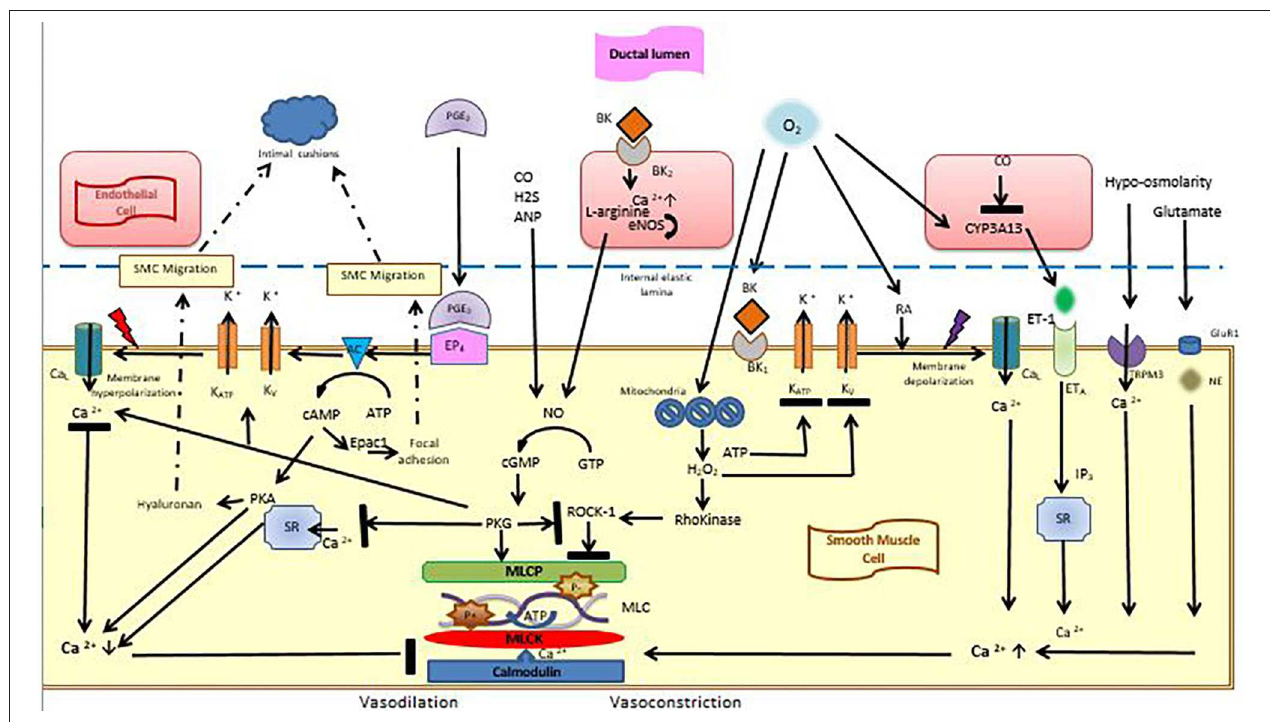
FIGURE 1 | Vasoconstrictive and vasodilatory effects in the ductal smooth muscle cell. Smooth muscle cells are lined with an internal elastic lamina, on which endothelial cells re¸side. Vasodilation is maintained by the interaction of PGE2 with its receptor EP4, which triggers potassium outflow through voltage-sensitive potassium channels, which leads to membrane hyperpolarization. Thereby, calcium entry into the cells decreases and binding of calmodulin to MLCK is inhibited. cAMP and cGMP are also effective during this process. After birth, high oxygen tension, which is sensed through the mitochondria triggers the formation of H 2 O 2 which blocks Rho-kinase pathway as well as potassium channels leading to membrane depolarization and calcium entry into cells. Calcium entry is also stimulated by endothelin-1, hypo-osmolarity and glutamate. Calcium activates MLCK, which leads to MLC phosphorylation and vasoconstriction. cAMP is also effective in smooth muscle migration and intimal cushion formation. AC, adenylyl cyclase; ANP, Atrial Natriuretic peptide; ATP, Adenosine Tri Phosphate; BK, Bradykinin; BK1, Bradykinin receptor; CaL, calcium channels; cAMP, cyclic adenosine monophosphate; cGMP, cyclic guanosin monophosphate; CO, Carbon monoxide; CYP3A13, cytochrome P450; eNOS, endogenous nitric oxide synthase; EP4, Prostaglandin receptor 4; ET-1, Endothelin-1; ETA, endothelin receptor A; epac, exchange protein activated cAMP; H2, Hydrogen sülfite; GluR1, glutamate receptor-1; KATP, KV, Voltage-dependent potassium channels; NE, Norepinephrine; MLC, Myosin Light Chain; MLCK, Myosin Light Chain Kinase; MLCP, Myosin Light Chain Phosphatase; NO, nitric oxide; PKA, cAMP-dependent protein kinase; PGE2, Prostaglandin E2; PKG, cGMP-dependent protein kinase; RA, Retinoic acid; ROCK-1, Rho-associated protein kinase-1; SR, Sarcoplasmic Reticulum; SMC, Smooth Muscle Cell; TRMP3, transient receptor potential melastatin 3 (Figure courtesy of Fahri Ovali).